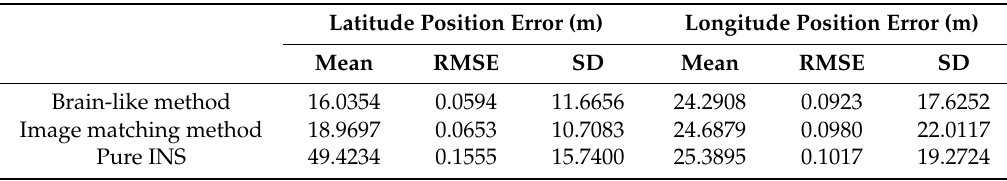
Figure 8. Place nodes of image matching. ( a ) The first place cell node; ( b ) The second place cell node; ( c ) The third place cell node; ( d ) The fourth place cell node. Table 1. Latitude and longitude errors (m). SD: standard deviation; INS: inertial navigation system; RMSE: root-mean-square